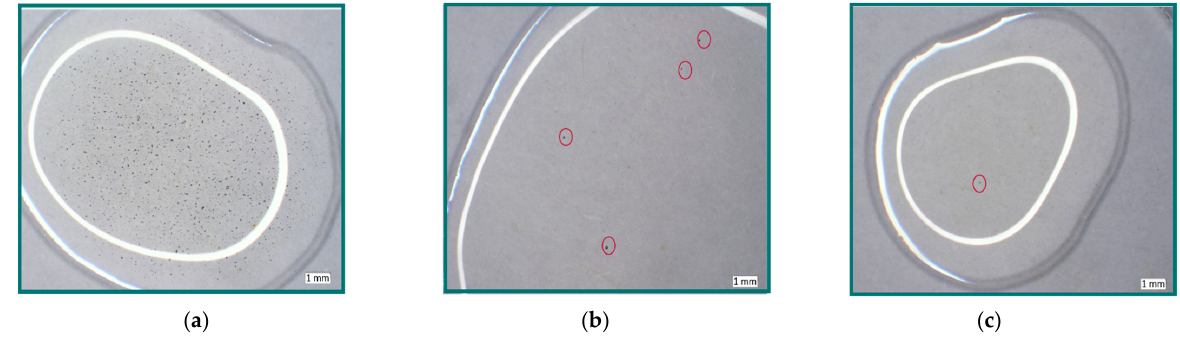
Figure 11. Oil samples: ( a ) Oil sample L 1 needs to be tested, 47 μ m, 333 PPM; ( b ) Oil sample L 2 needs to be tested, 100 μ m, 83 PPM; ( c ) Oil sample L 3 after